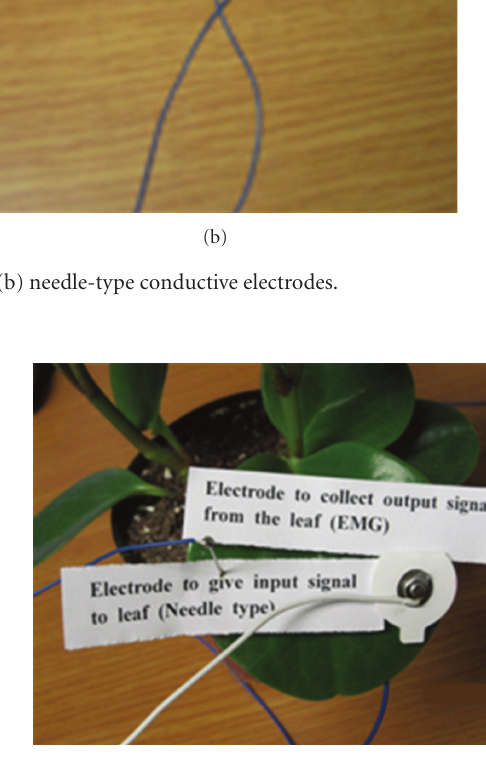
Figure 4: Insertion of EMG electrode and needle-type conductive electrode (by wounding the